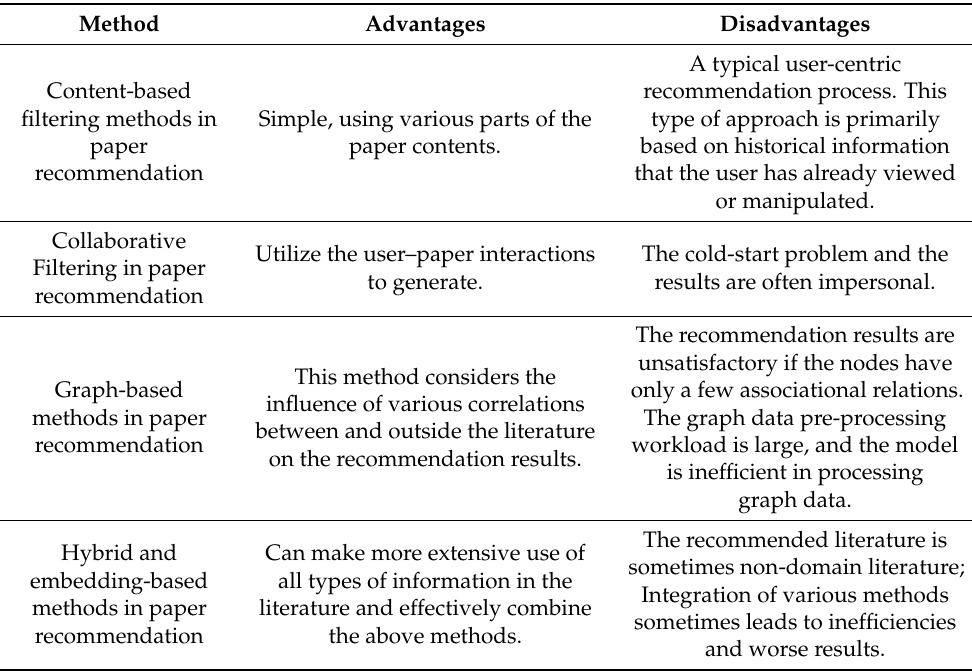
Table 1. Advantages and disadvantages of different methods in literature